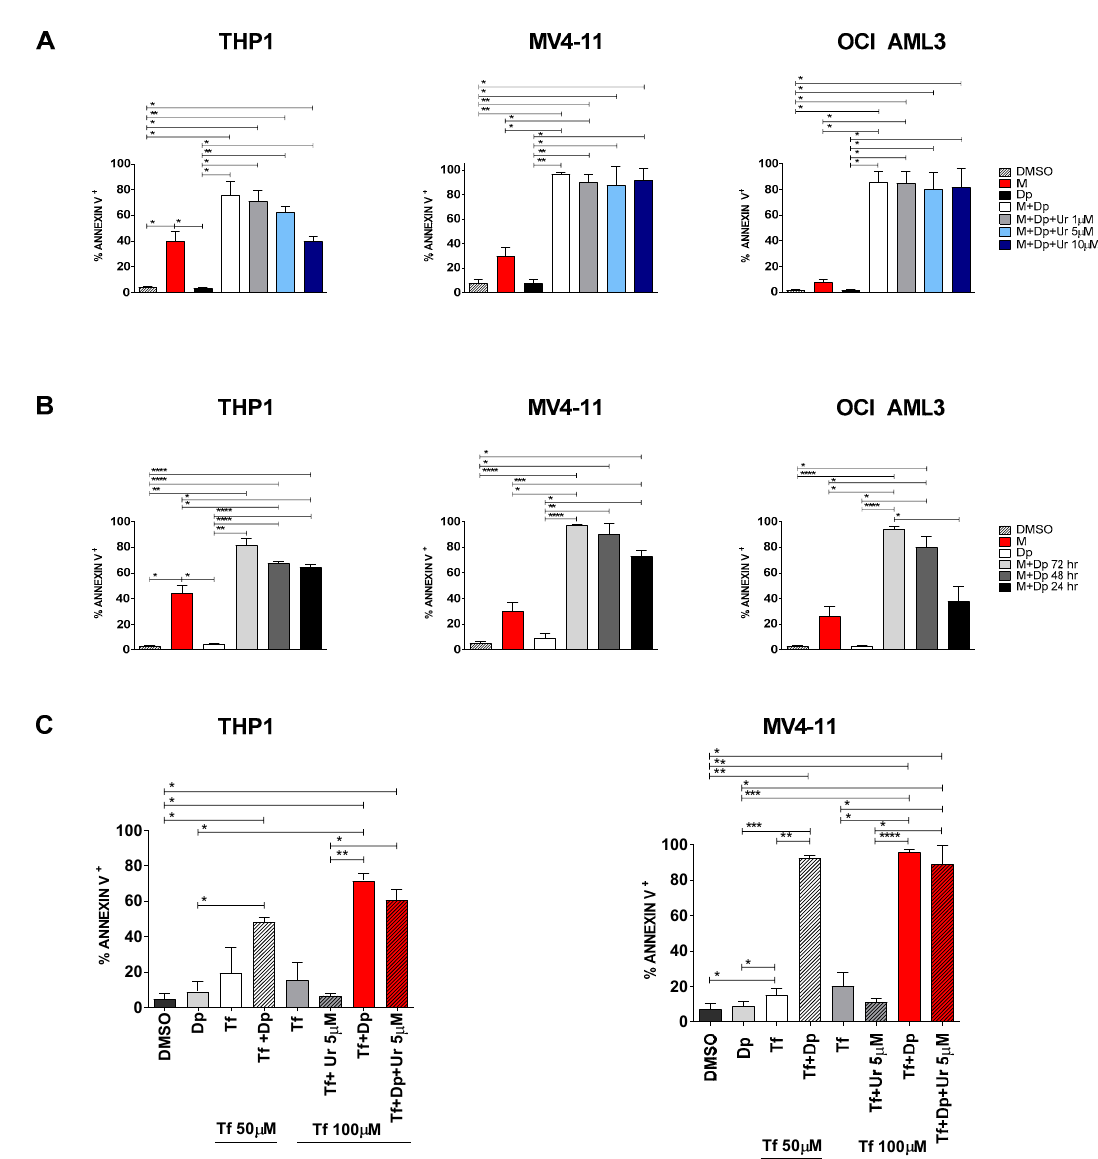
Figure 7. The synergism between DHODH inhibitors and dipyridamole is confirmed when in vivo conditions are mimicked. ( A ) Apoptosis induced by MEDS433 in combination with dipyridamole in the presence of uridine at low concentrations (1 to 10 µ M) on THP1 ( n = 3), MV4-11 ( n = 3) and OCI AML3 cells ( n = 3). ( B ) Cells were exposed to MEDS433 for 3 days and to dipyridamole for 3, 2 or 1 concomitant day(s), as shown in the figure legend; apoptosis was then evaluated on day 3 ( n = 3). ( C ) Apoptosis induced by teriflunomide, dipyridamole and their combination, alone or in the presence of physiological uridine concentrations (5 µ M), on THP1 ( n = 3) and MV4-11 cells ( n = 3). DMSO: dimethyl sulfoxide. M: MEDS433. Dp: dipyridamole. Ur: uridine. Tf: teriflunomide. Statistical significance: Anova/Tukey, * p < 0.05; ** p < 0.01; *** p < 0.001; **** p < 0.0001.